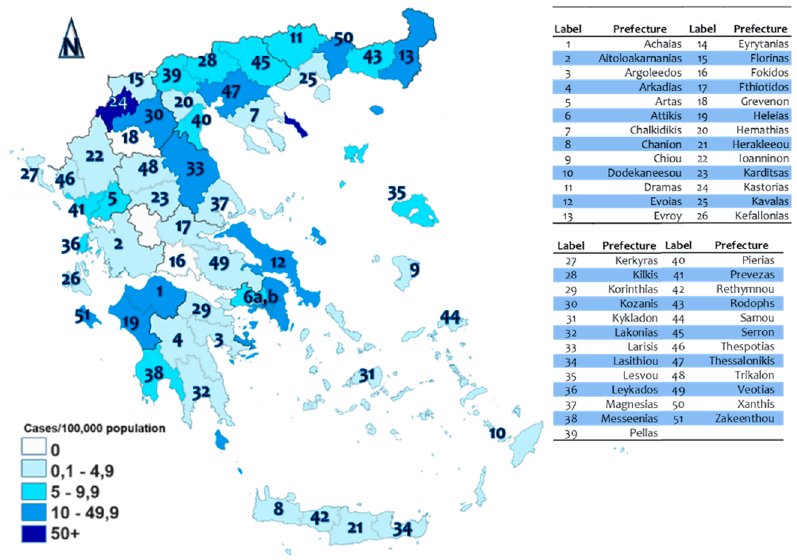
Figure 2. Infected cases per million in Greece (source: [27]).